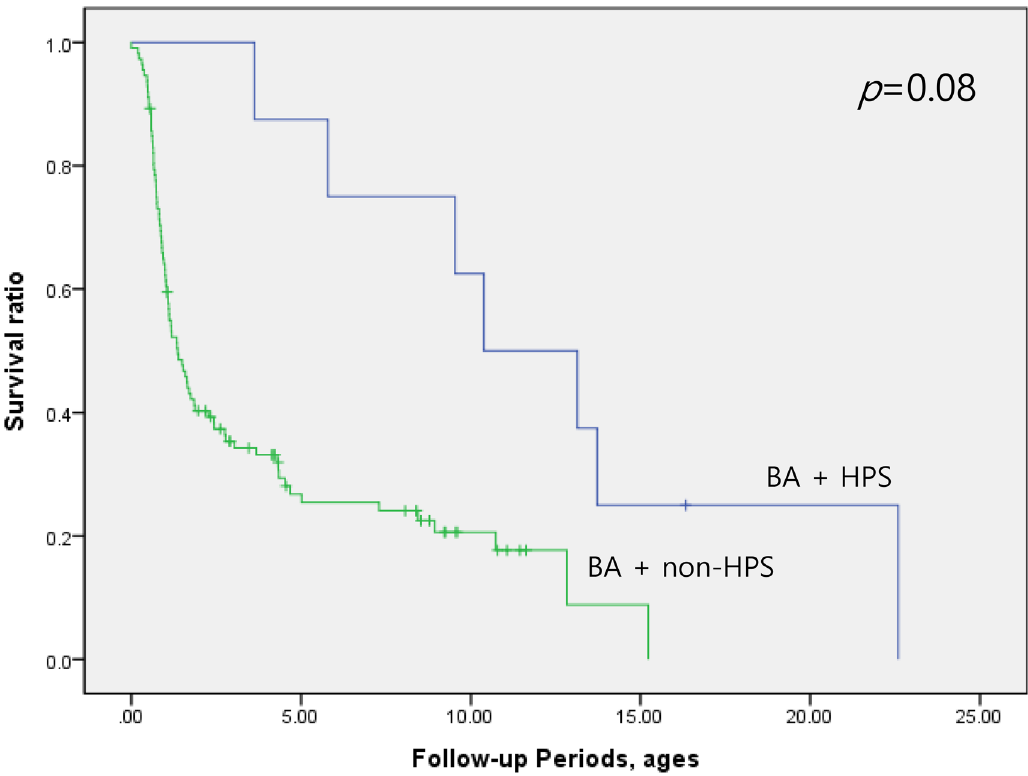
Figure 1. Comparison of 10-year LT-free survival rate between BA with HPS and BA without HPS. The Kaplan–Meier survival analysis showed that the 10-year LT-free survival rate did not differ significantly between BA patients with and without HPS ( p =